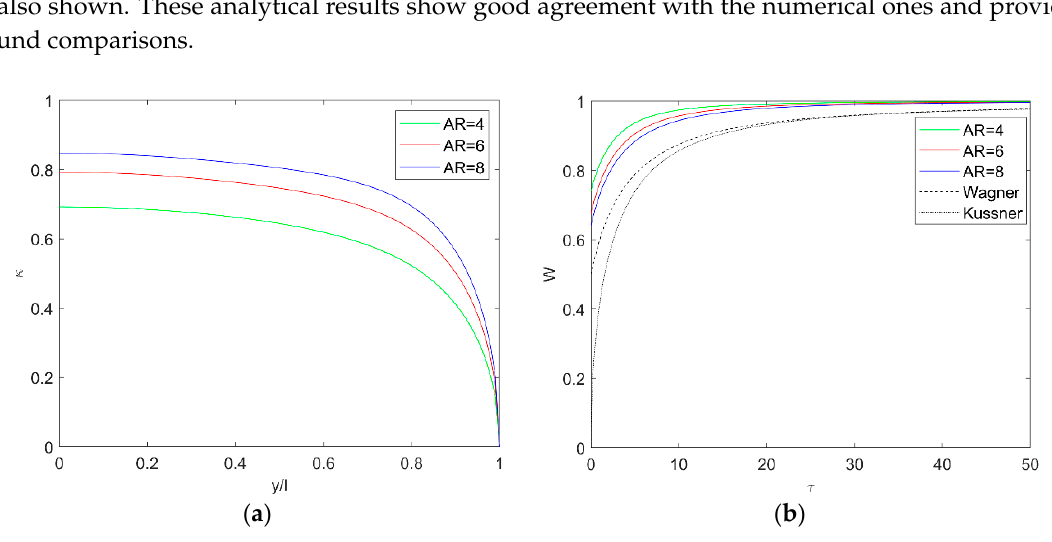
Figure A1. Lift-scaling ( a ) and lift-deficiency ( b ) functions for flat rectangular wings of different aspect ratios.